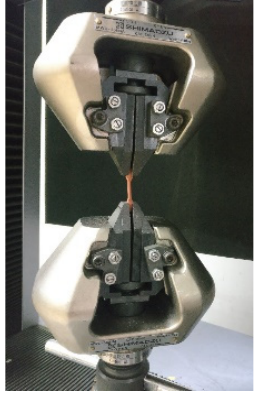
Figure 4. Fixture and sample.